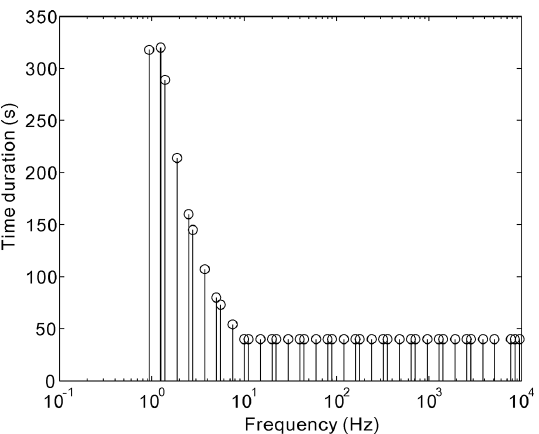
Figure 2. Stack time length for a typical CSAMT frequency step- ping schedule.